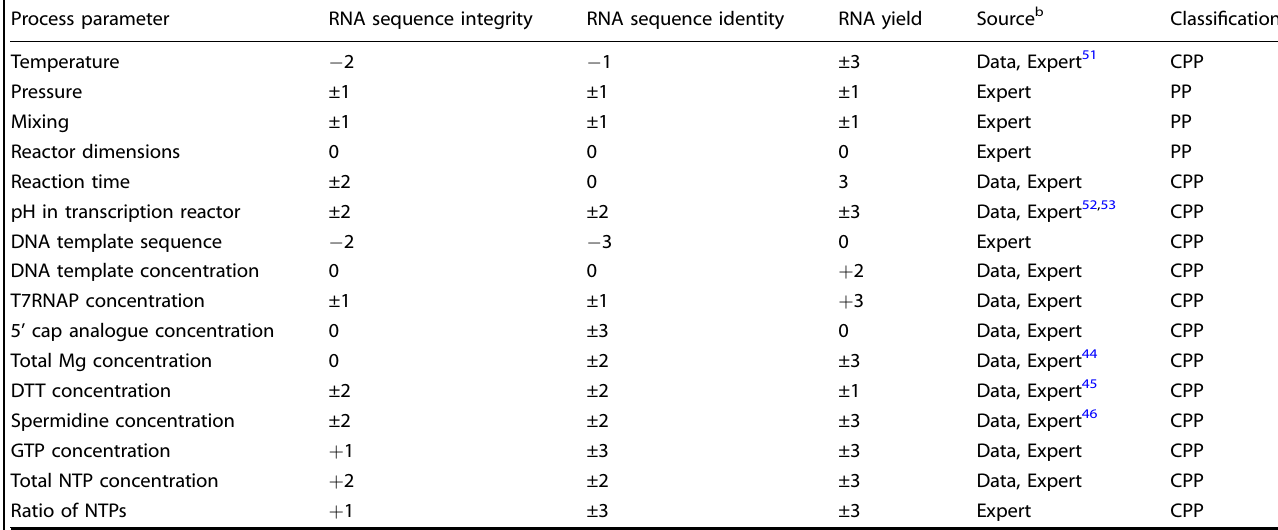
Table 1. Proposed qualitative framework for the assessment of the criticality of process parameters (PPs) based on the qualitative assigned impact of PPs on the CQAs a . Process parameter